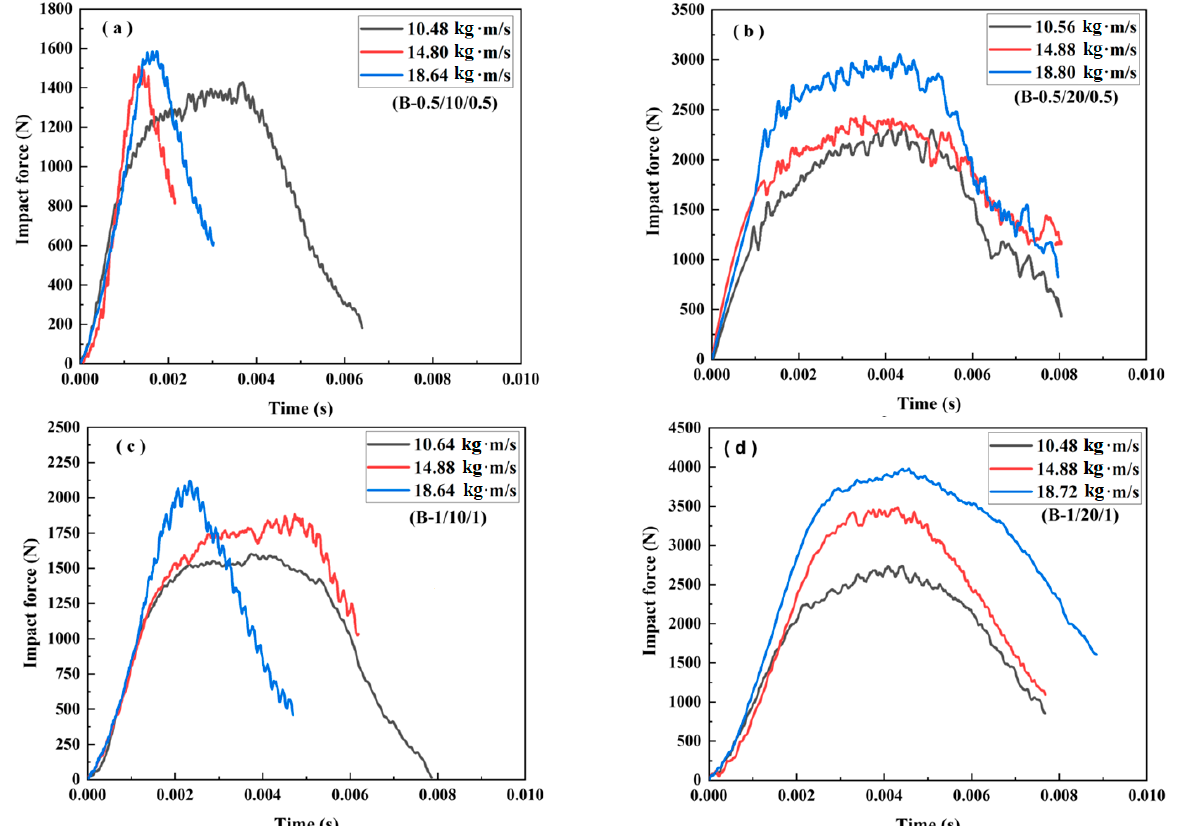
Figure 6. The failure modes of the sandwich beams: ( a ) A-0.5/10/0.5; ( b ) A-0.5/20/0.5; ( c ) A-1.0/10/1.0; ( d ) A-1.0/20/1.0.